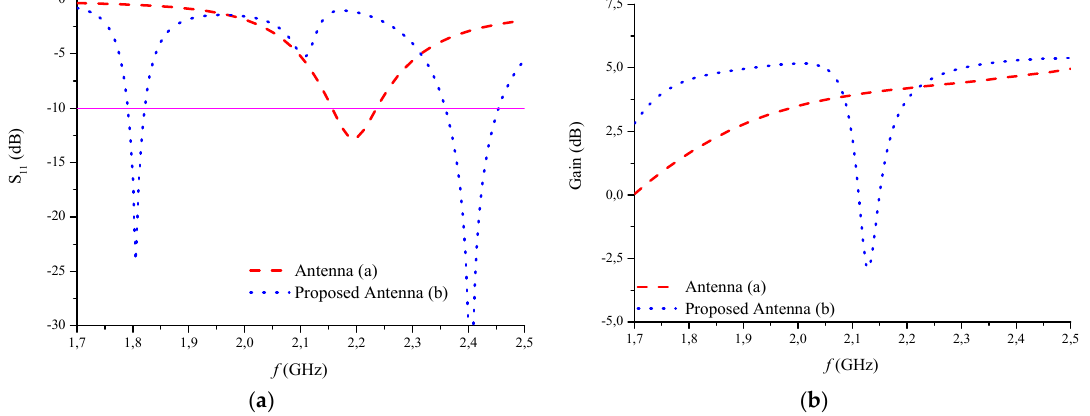
Figure 3. ( a ) Simulated S 11 of antennas; ( b ) Simulated gain of the two antennas depicted in Figure 2.